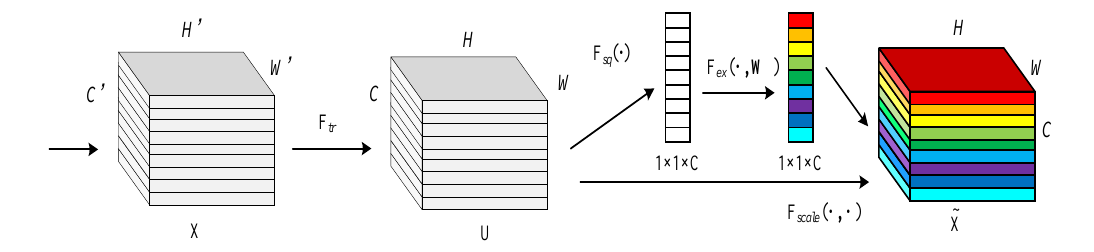
Figure 3. Squeeze and excitation module structure (Copyright IEEE, 2022.).